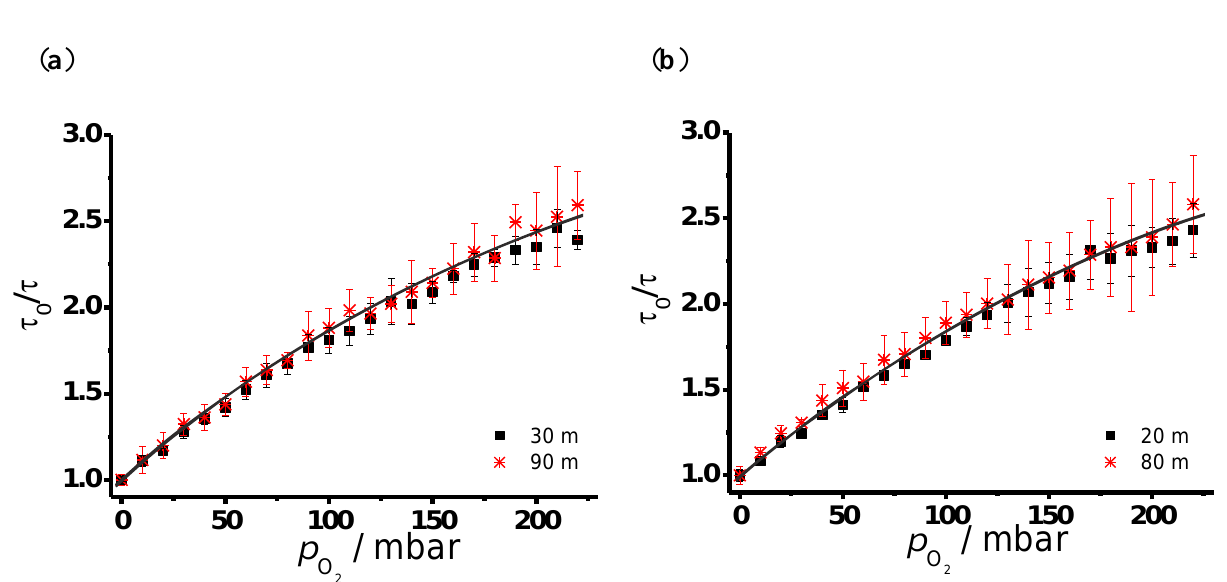
Figure 7. Stern-Volmer plots of TP in silicone ( a ) measured with the branched fiber model ( b ) the single linear fiber